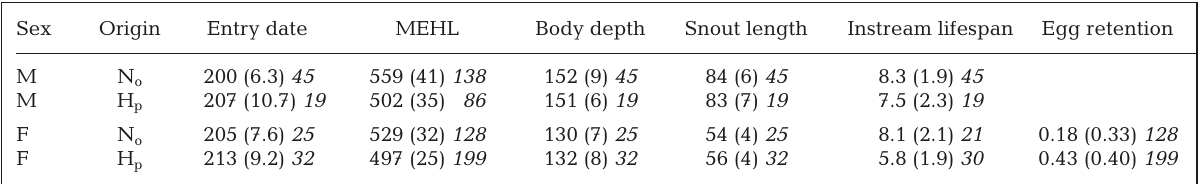
Table 2. Mean trait values for groups of hatchery-produced (H p ) and natural-origin (N o ) chum salmon of both sexes, with SD in parentheses and sample sizes italicized. Unit for entry date is day of year (where Day 200 corresponds to 19 July); mid-eye to hypural length (MEHL), body depth, and snout length are mm; instream lifespan is days spent alive in freshwater; egg retention is proportion of eggs remaining in body cavity after natural death (range for both wild and female egg retention was 0.0 to 1.0)